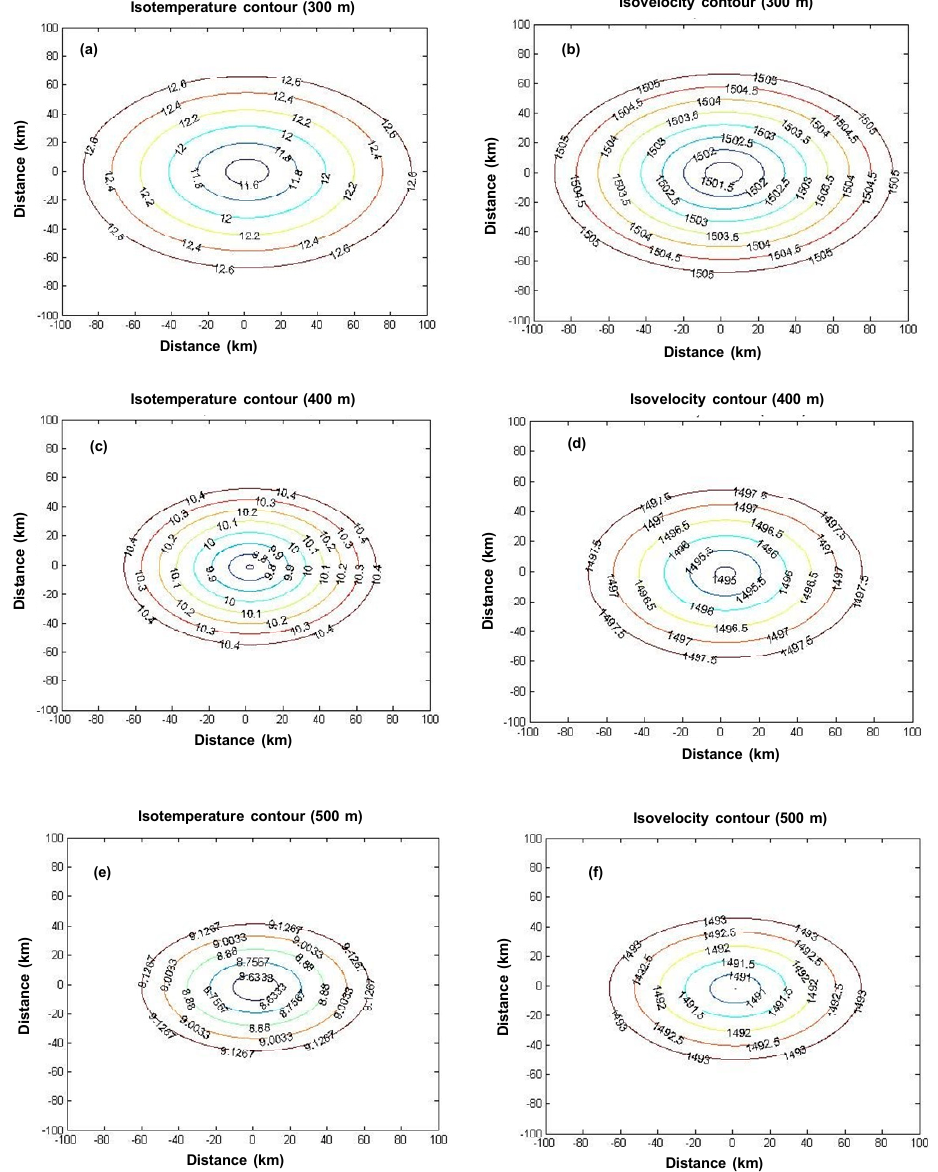
Figure 5. Interpolation plots of temperature (°C) distribution in the horizontal direction at different depths and the corresponding interpolation distribution plots of sound velocity (m/s): ( a , c and e ) Isotemperature contour is 300, 400 and 500 m, ( b , d and f ) Isovelocity contour is 300, 400 and 500 m.